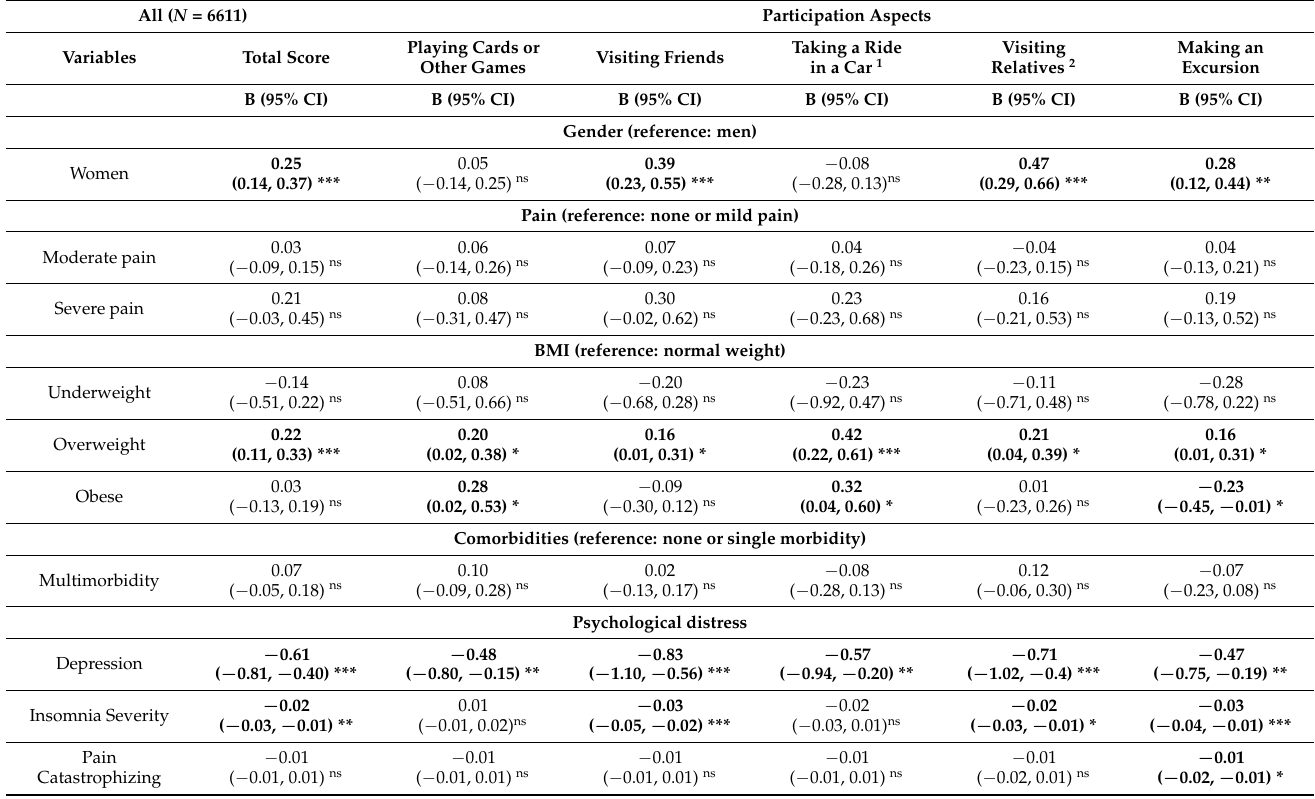
Table 3. Results of multivariable regression analysis on total participation and participation aspects for the total sample adjusted for age, marriage status, education level, and yearly income level. All ( N =